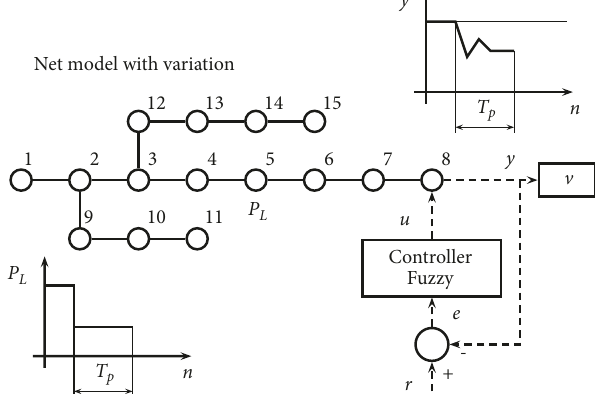
Figure 5: Operation of the control system when load variation occurs.